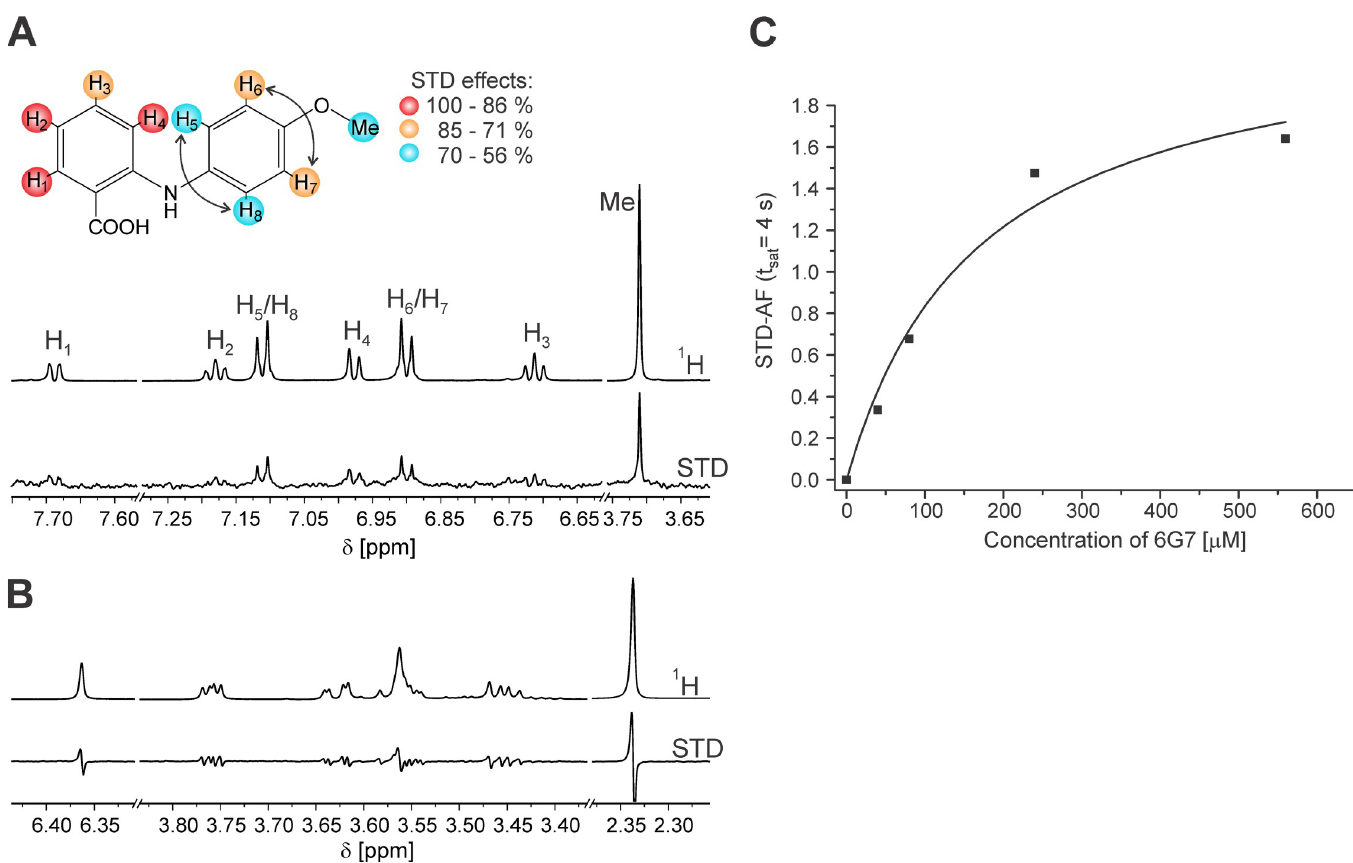
Fig 4. Saturation transfer difference-nuclear magnetic resonance (STD-NMR) analysis of 6G7. (A) 1 H and STD-NMR spectra of ligand 6G7 in the presence of NLP Pya . The NMR spectra were recorded at 25˚C, 4 s saturation time, 400 μ M ligand concentration, and 1:50 receptor-to-ligand ratio in 25 mM Tris- d 11 and 150 mM NaCl in 2 H 2 O and 5% DMSO- d 6 at 600 MHz. Signals are labeled according to the atom numbers shown in the scheme, in which the relative degree of hydrogen atom saturation is marked with a corresponding color scale normalized to H 1 . Arrows indicate the overall STD effects for the symmetric atoms H 5/8 and H 6/7 . (B) 1 H and STD-NMR spectra of 6E11 in the presence of NLP Pya under the same experimental conditions as in (A). (C) STD-amplification factor as a function of 6G7 concentration (0 − 560 μ M). Experimental data were fit to Eq